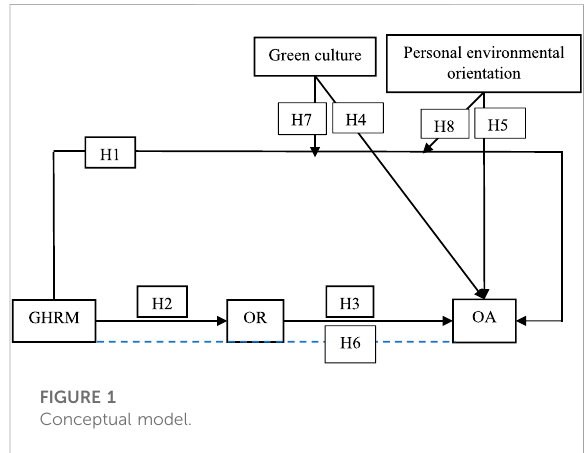
Figure 3 re fl ects that the total effect of GHRM on OA ( β =